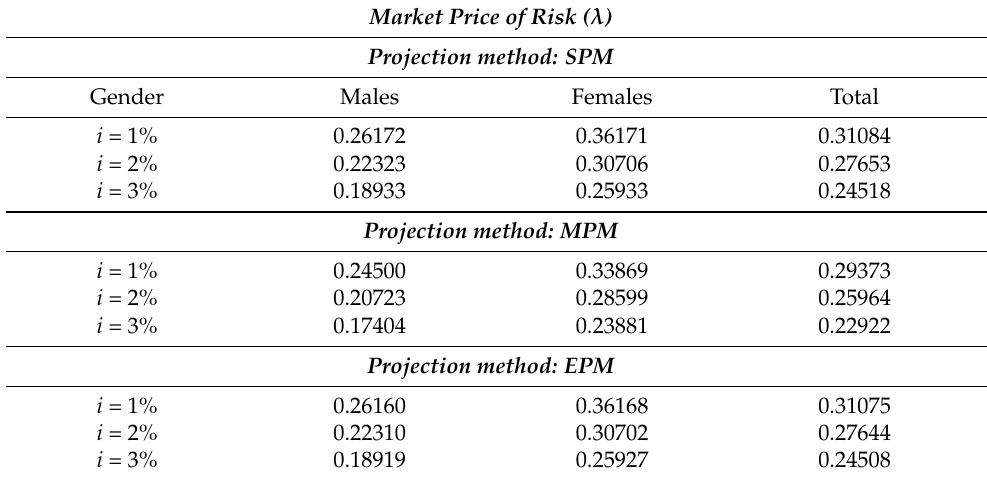
Table 1. Market price of risk values under each projection method with i varying from 1 to 3 percent.